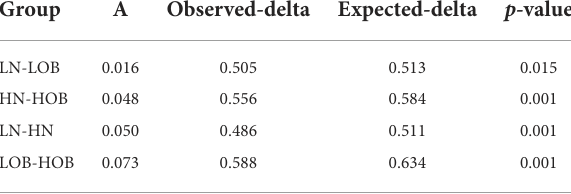
TABLE 3 MRPP analysis of differences in microbial community structure between groups. Group